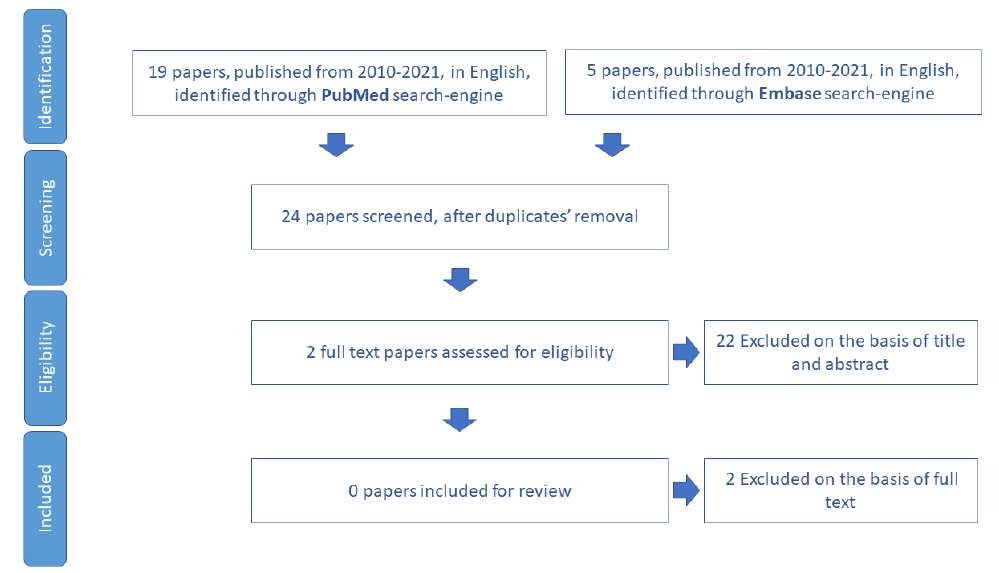
Figure 10. Process of study selection for assessment of economic constraints.